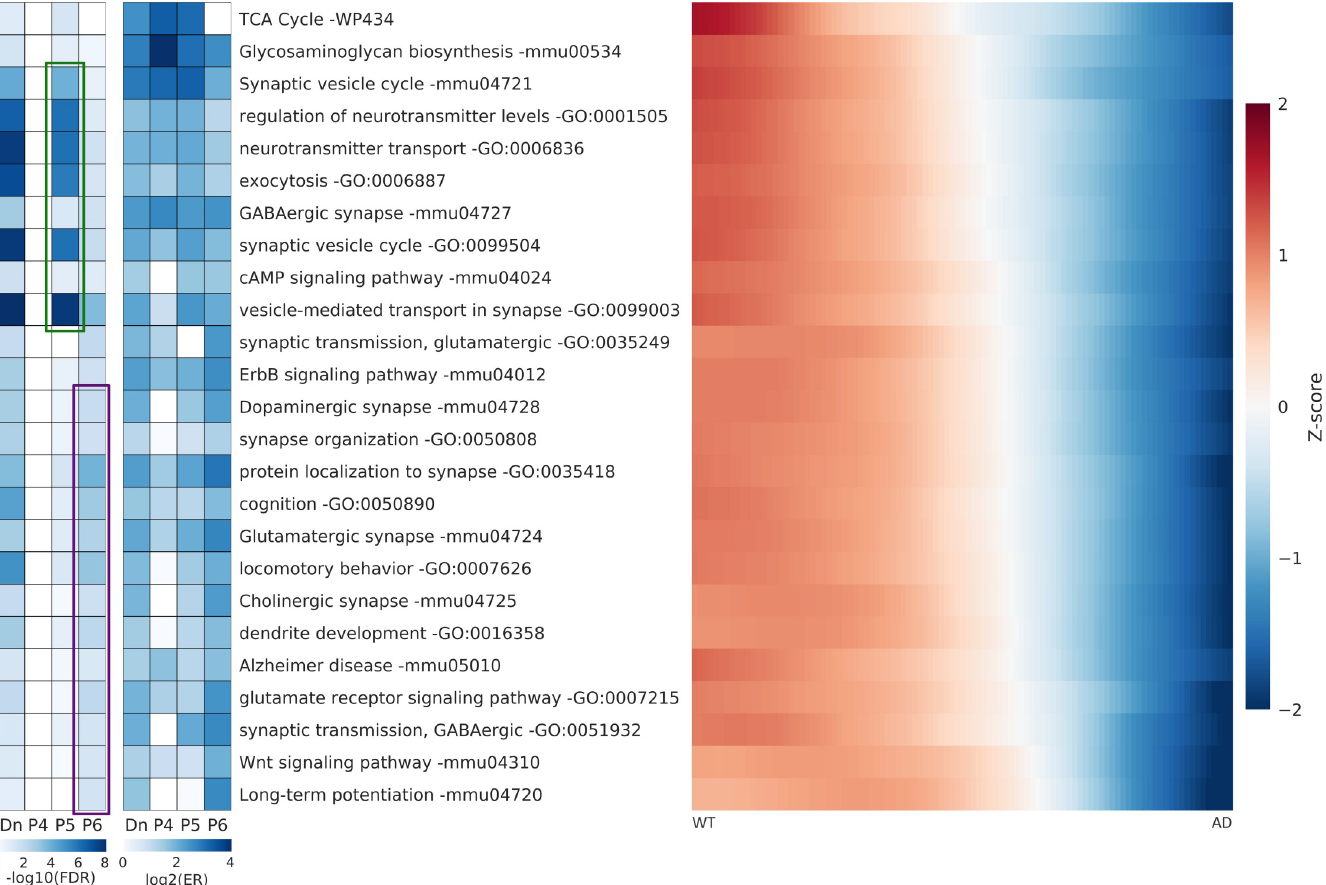
Fig 5. The false discovery rate and enrichment ratio value for downregulated pathways. The false discovery rate (FDR) and enrichment ratio (ER) values for the selected pathways estimated by the gene list of each subset (Down, P4, P5, P6). Each pathway heatmap was estimated by averaging the transition curves of the genes belonging to the Down list. Genes were significantly downregulated for pathways involving the exocytosis of neurotransmitters with lower P5 FDR (the green box) and of specific synaptic functions with lower P6 FDR (the purple box).